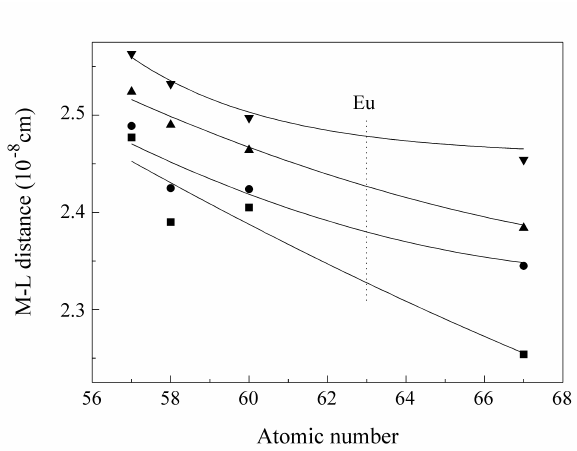
Figure 4. Metal-ligand (M-L) distance of LnNbO 4 (Ln = La 3+ , Ce 3+ , Nd 3+ , Ho 3+ ) vs. atomic